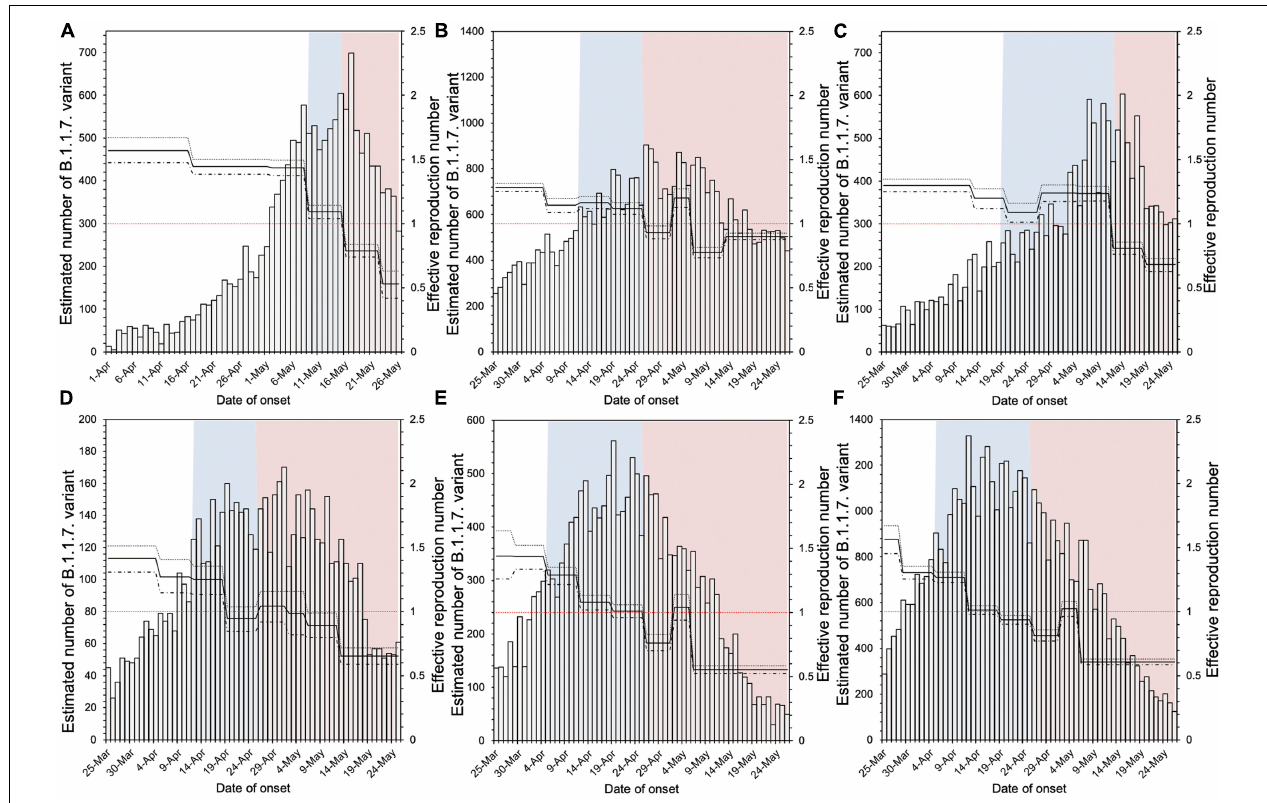
FIGURE 1 | Estimated effective reproduction number in six prefectures implementing both pre-emergency measures and a state of emergency. (A–F) in the figure correspond to Hokkaido, Tokyo, Aichi, Kyoto, Osaka, and Hyogo prefectures, respectively. The blue shaded areas indicate the period of pre-emergency measures, and the red shaded areas indicate the state of emergency period. The bar graph is the estimated number of infections with the B.1.1.7 variant by onset date, and the solid line is the effective reproduction number ( R t ). Using the 7 days before implementation of pre-emergency measures as the baseline, we compared the R t for the 7 days immediately after the start of each